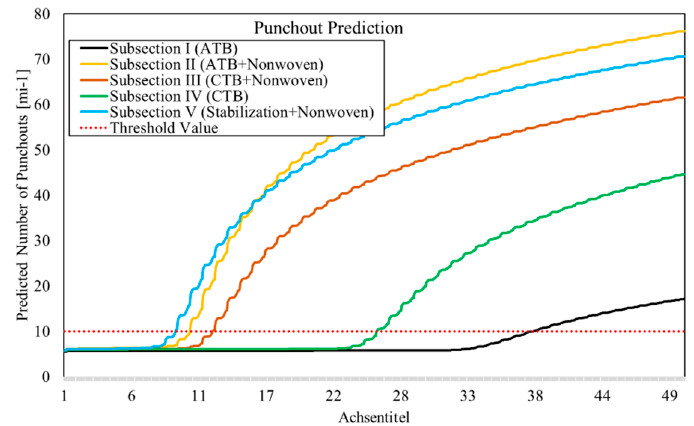
Figure 11. Prediction of punchout by increased slab thickness on the A5